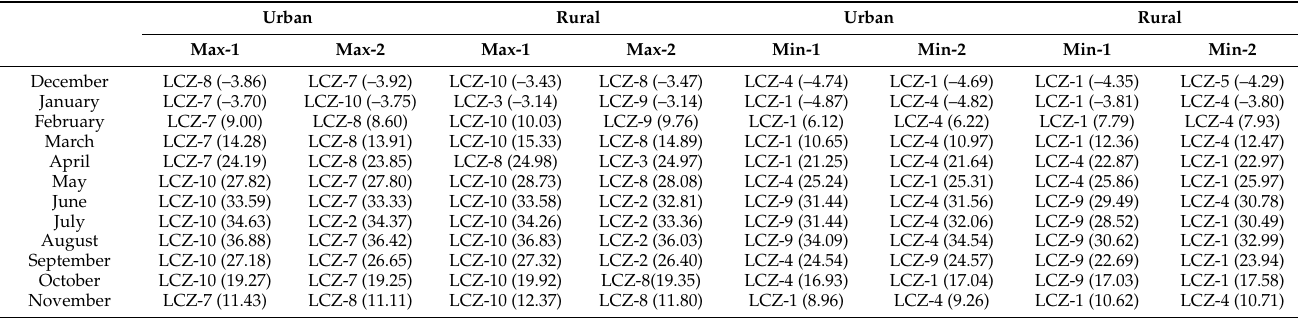
Table 4. The maximum and minimum temperatures in different months and corresponding built local climate zones within urban and rural contexts ( ◦